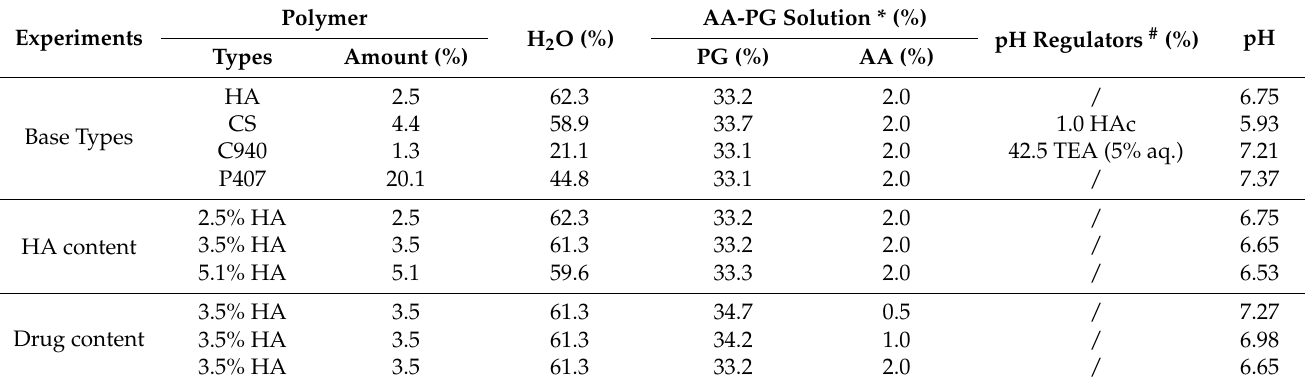
Table 1. Prescriptions of AA-loaded hydrogels with different polymers as